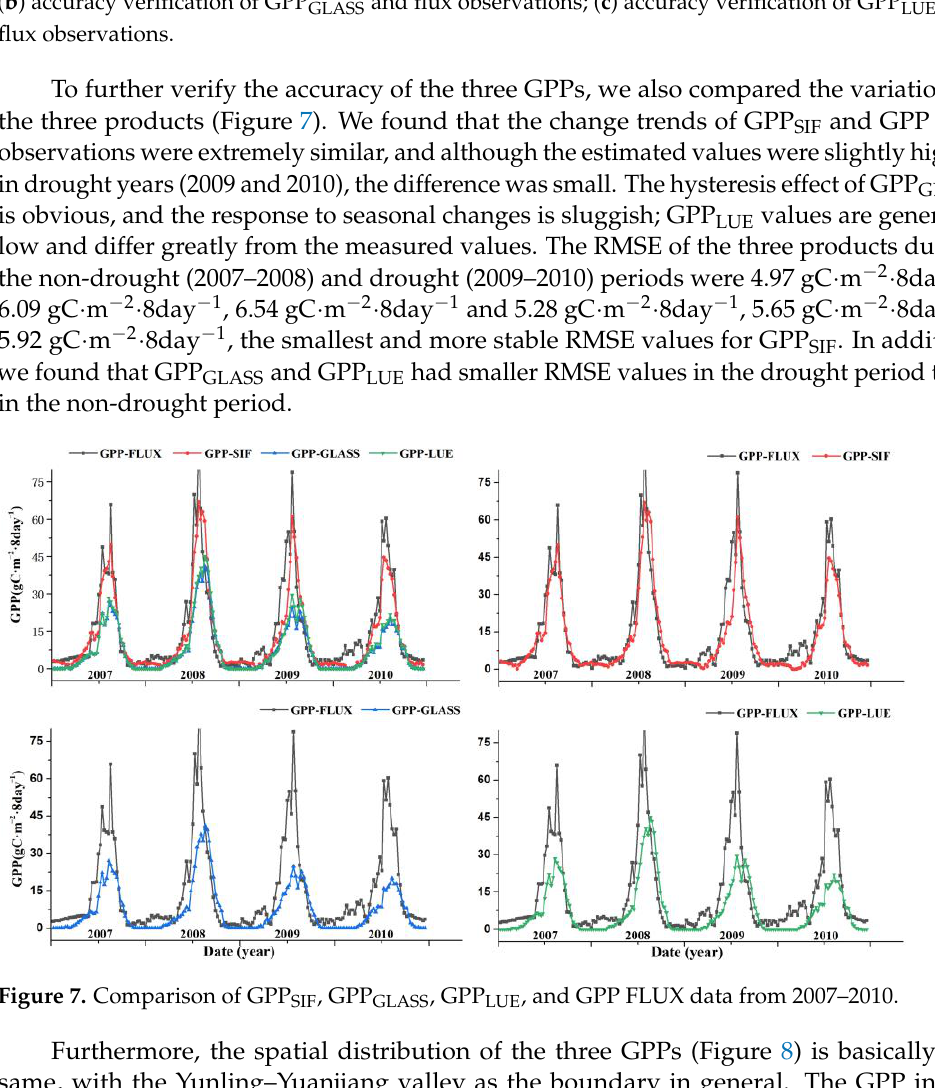
Figure 6. GPP accuracy verification. ( a ) accuracy verification of GPP SIF and flux observations; ( b ) accuracy verification of GPP GLASS and flux observations; ( c ) accuracy verification of GPP LUE and flux observations.